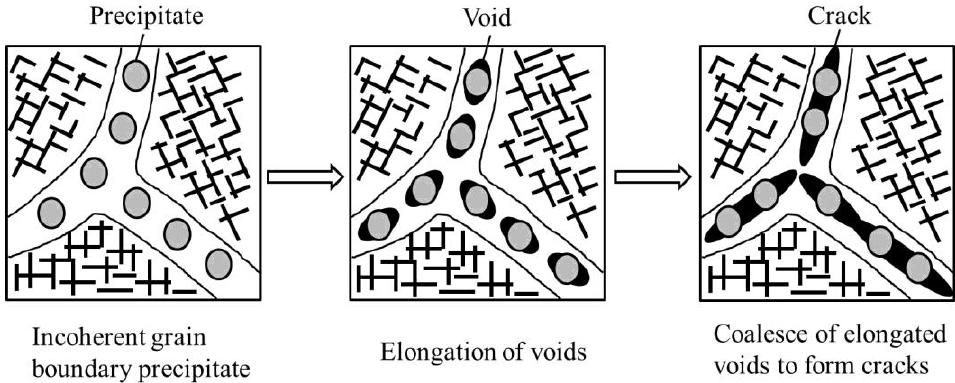
Figure 10. Schematic diagram about the effect of GBPs on microcrack